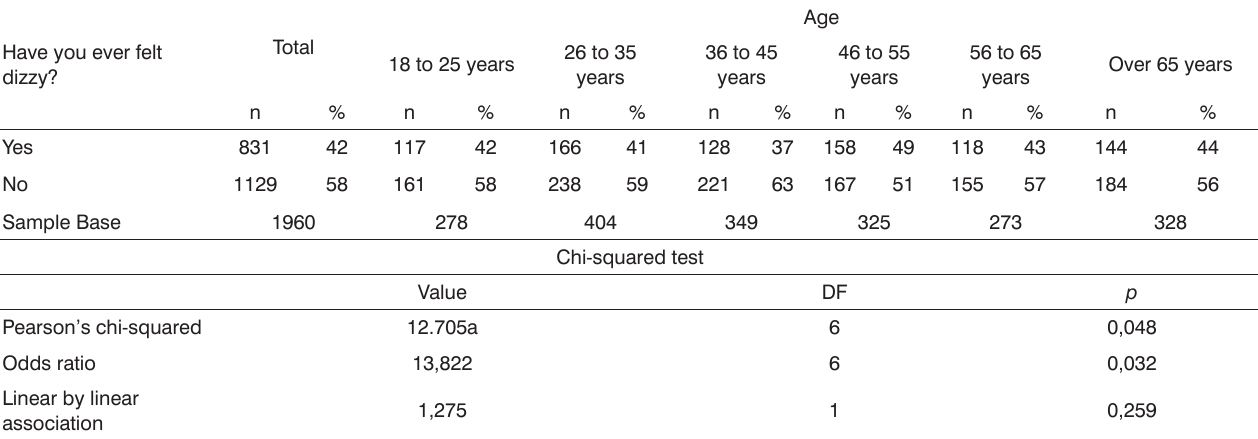
Table 3. The "dizzy feeling" complaint prevalence according to the various age groups in the population of the city of São Paulo.